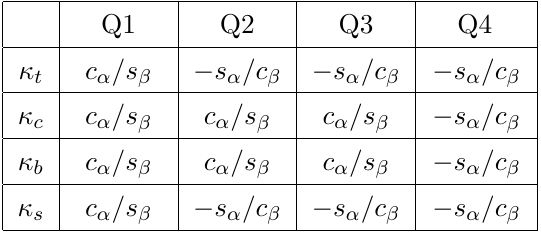
Table 4 . Approximate κ f parameters for the models Q1 -